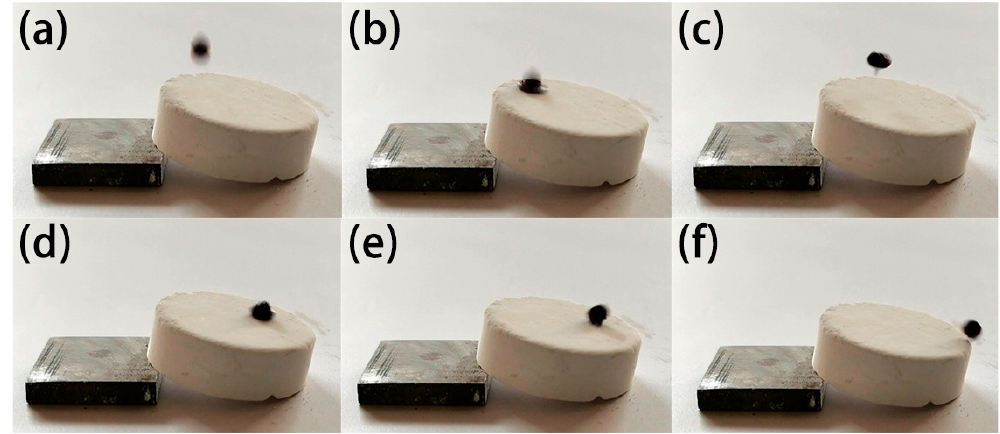
Figure 3. ( a – f ) Digital photo of water drop bouncing on the superhydrophobic surface.